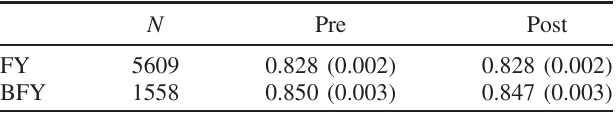
TABLE III. Average (standard error) of the fraction of items answered favorably on both the pre- and post-tests for students in FY and BFY courses for the question targeting students pre- dictions of expertlike